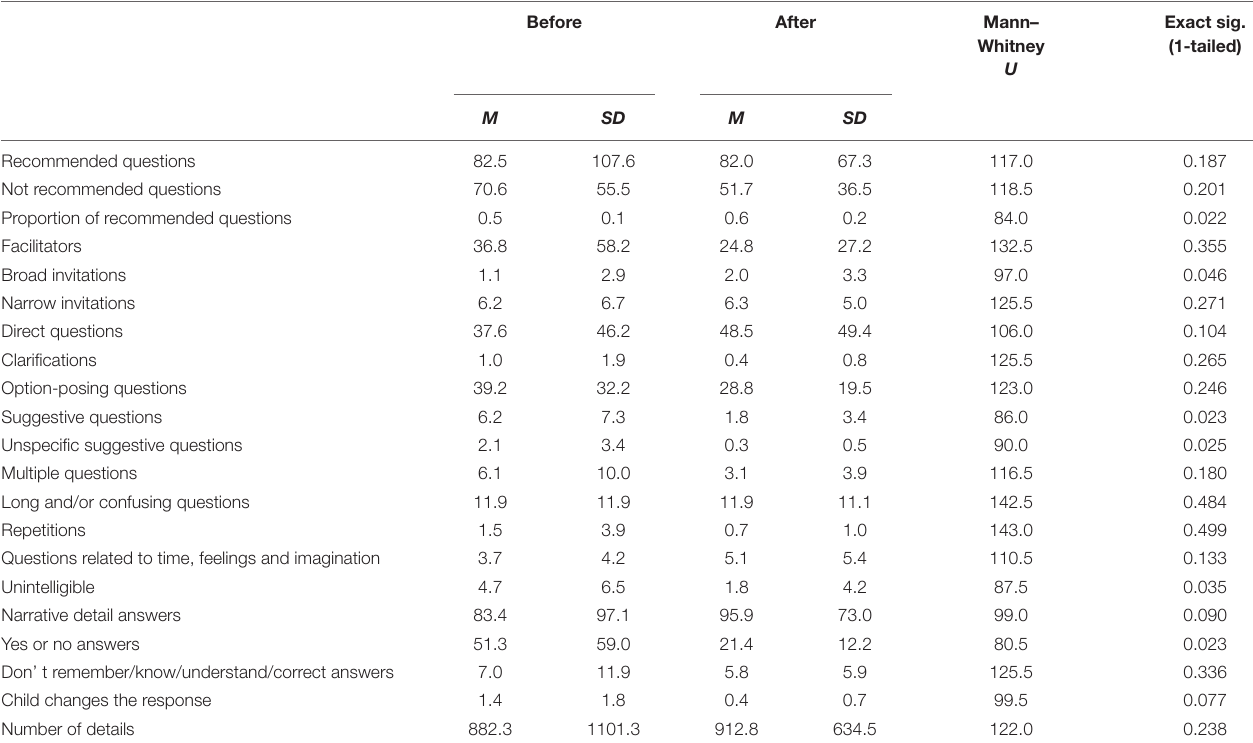
Before After Mann–